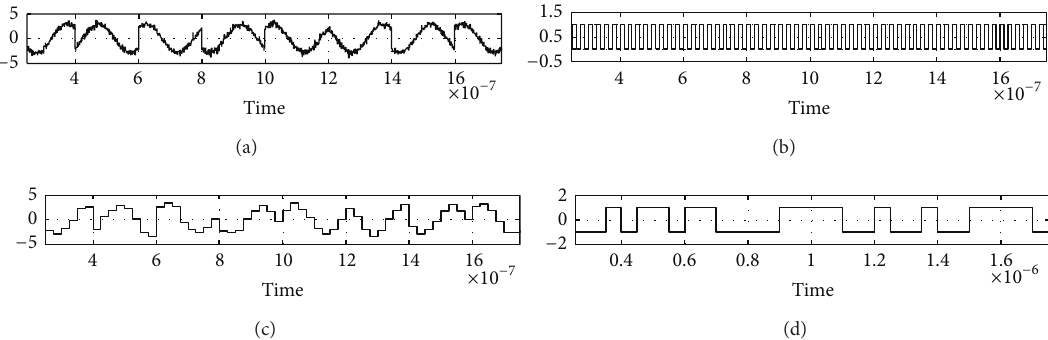
Figure 2: (a) The QPSK signal, (b) sampling time, (c) output from sampled QPSK signal, and (d) four samples obtained from the sampled QPSK signal.